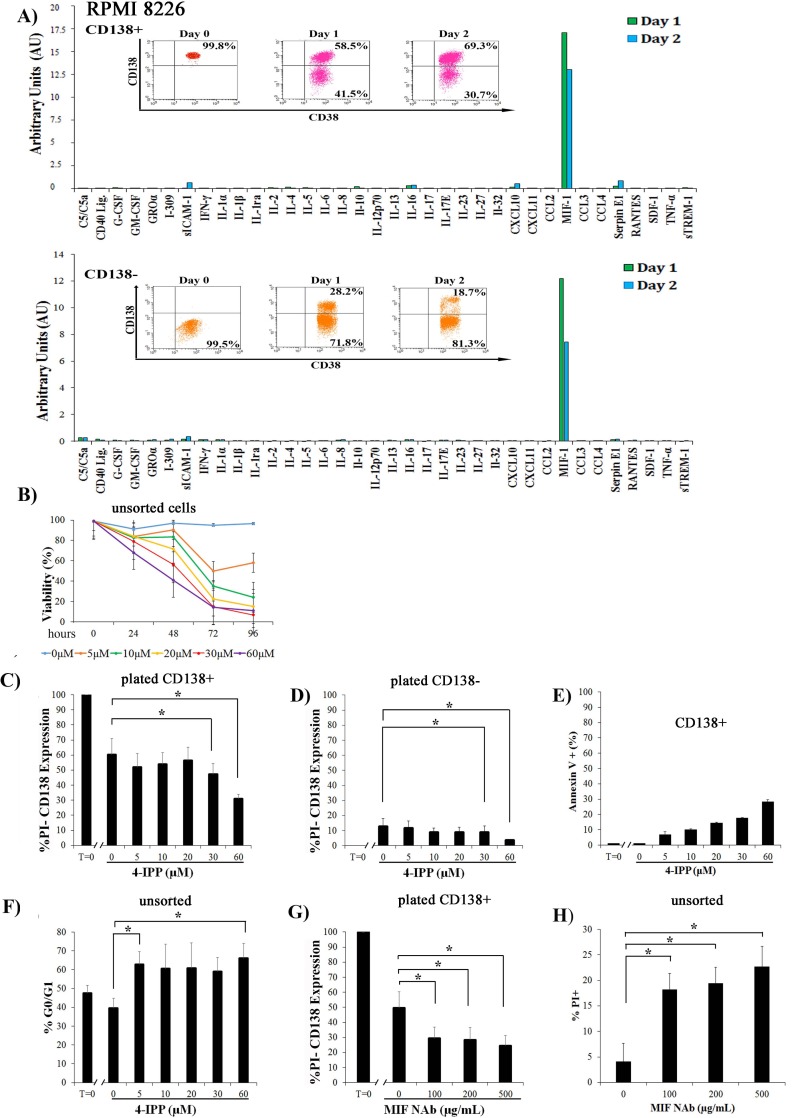
MIF-1 regulates differentiation status of RPMI 8226 cells.A) Sorted CD138+ or CD138- cells were plated and media was harvested at T0, T24 and T48 and used in the cytokine array assay. AU plotted as the expression of 36 different cytokines. Representative of N = 3 (CD138+) and N = 2 of (CD138-). Inset: CD138 and CD38 status at each time point, assessed by flow cytometry, to verify differentiation and dedifferentiation of populations during the timecourse. B) Viability measured by PI staining of cells treated with different concentrations of 4-IPP for different timepoints. (N = 3). C) Sorted populations of CD138+ or D) CD138- cells were plated and then treated with increasing concentrations of 4-IPP for 24 h. Cells were stained with CD138 and PI and expression of CD138 in viable (PI negative) cells is plotted (N = 3). T = 0 is CD138 content at time of plating before 4-IPP treatment. E) Sorted CD138+ cells were plated, treated with increasing concentrations of 4-IPP for 24 h. and then stained with Annexin V, followed by flow cytometric (N = 3) Test of trend, p = 0.008. F) Unsorted cells were plated, treated with increasing concentrations of 4-IPP for 24 h., and then stained with Vybrant Green, followed by cell cycle analysis (N = 3). G) Sorted CD138+ cells were plated, treated with increasing concentrations of MIF Nab for 24 h. Cells were stained with CD138 and PI and expression of CD138 in viable (PI negative) cells is plotted (N = 3). T = 0 is CD138 content at time of plating. H) Unsorted cells were plated, treated with increasing concentrations of MIF NAb for 24 h. Viability was measured by PI staining (N = 3). *p<0.05. Error bars, mean ± SD.